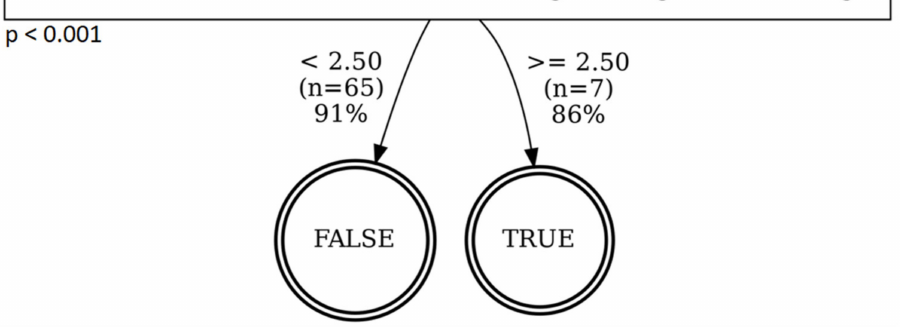
Figure 2. Decision-tree analysis of baseline demographic variables to predict surgery in IBD patients not enrolled in